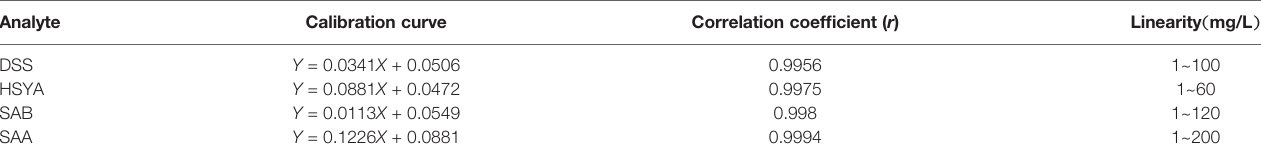
TABLE 1 | Linearity for the analysis of danshensu (DSS), hydroxysaf fl or yellow A (HSYA), salvianolic acid B (SAB), and salvianolic acid A (SAA) under standard solutions. Analyte Calibration curve Correlation coef fi cient ( r )